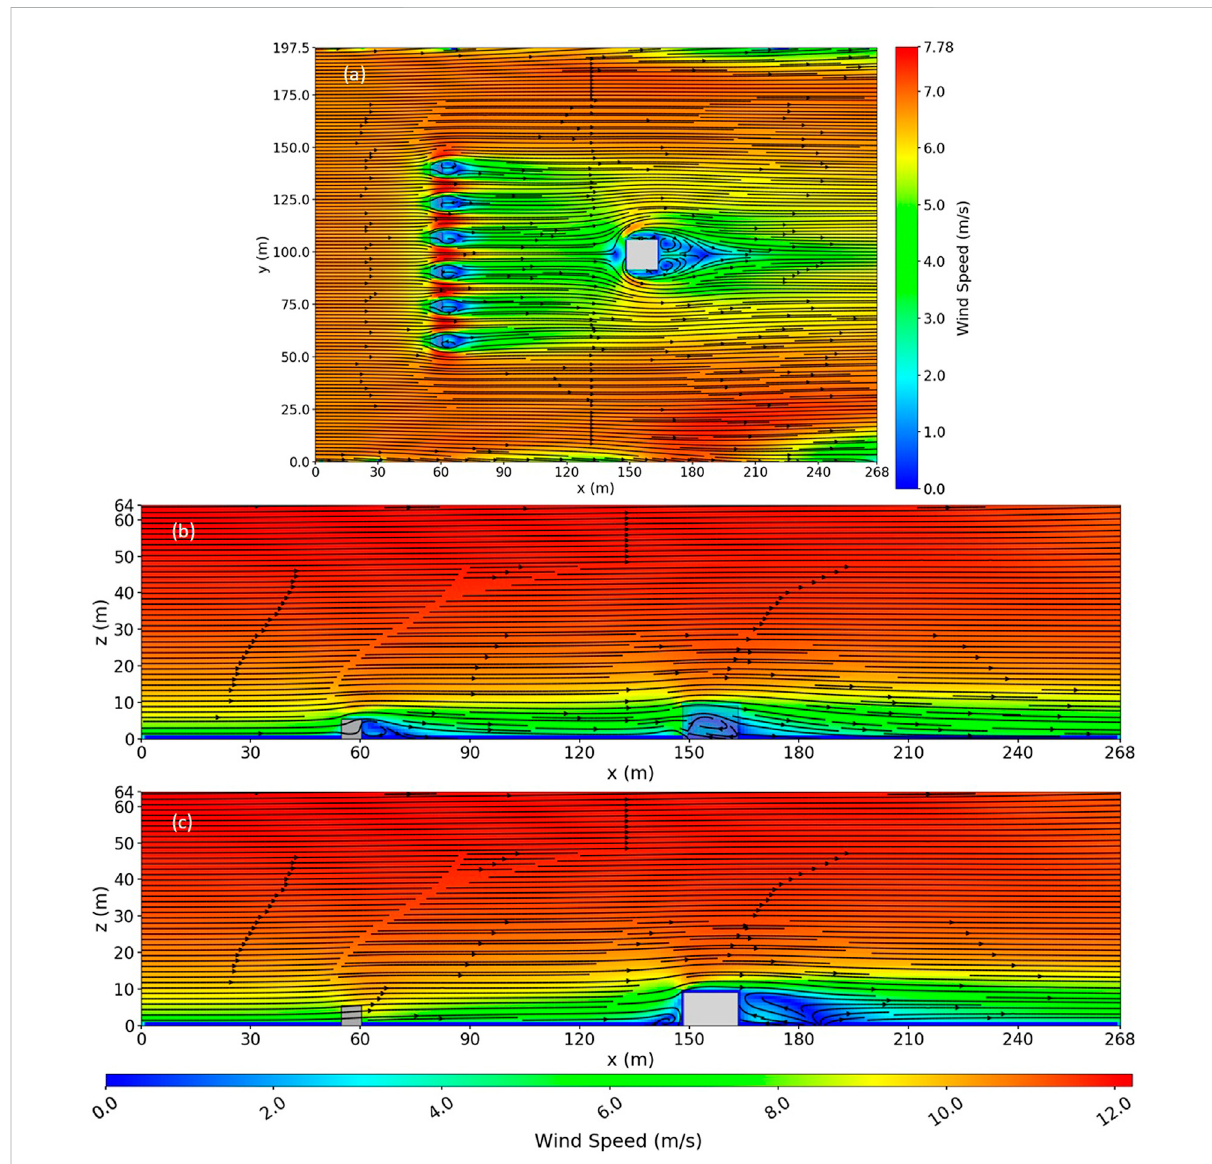
FIGURE 11 Simulated wind fi eld for 2W gap vegetation spacing with both fence and house present in the fl ow. (A) Top view slice at z = 1.4 m, which is the cell center of the second cell above the ground. (B) Side view slice down the middle of the tree just to the left of the middle gap at y = 107 m, just to the left of the house. (C) Side view slice down the middle of the middle gap at y = 99 m, down the center of the domain, and down the center of the house, still within the region of the